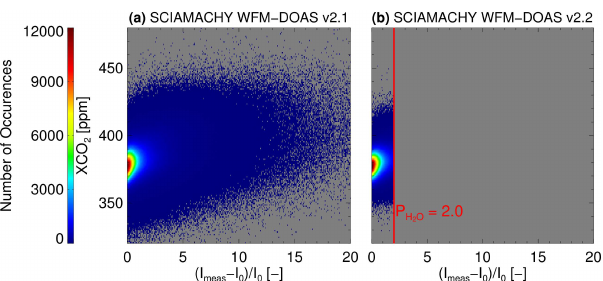
Fig. 1. Deviations between measured sun-normalised radiances (in- tensity) spectrally averaged between 1.395–1.41µm (I meas ) and the reference intensities (I 0 ) for SCIAMACHY WFM-DOAS version 2.1 (a) and 2.2 (b) using all data of the years 2003–2009. (a) A 2- D histogram of X CO 2 as a function of the deviation between I meas and I 0 . (b) as in (a) but for WFMDv2.2. The red line indicates the = 2 . 0). cloud filtering threshold ( P H 2 O